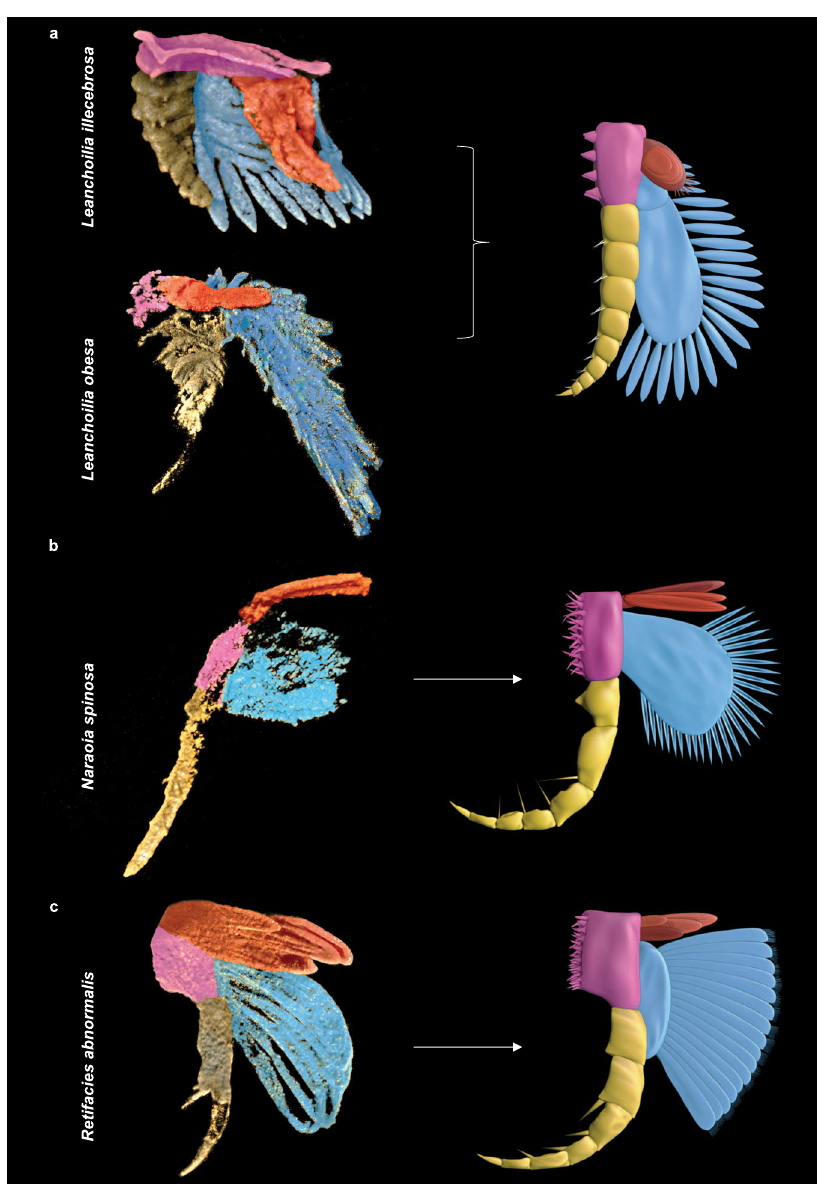
Fig. 3 Three-dimensional models of exite-bearing appendages. a Leanchoilia illecebrosa and Leanchoilia obesa . b Naraoia spinosa . c Retifacies abnormalis . Protopodite, endopodite and exopodite are coloured in pink, yellow and blue, respectively. Exite is in red and has not previously been detected. Not to scale. Digitally dissected protopodite, endopodite, exopodite, and exite are shown in Supplementary Fig.